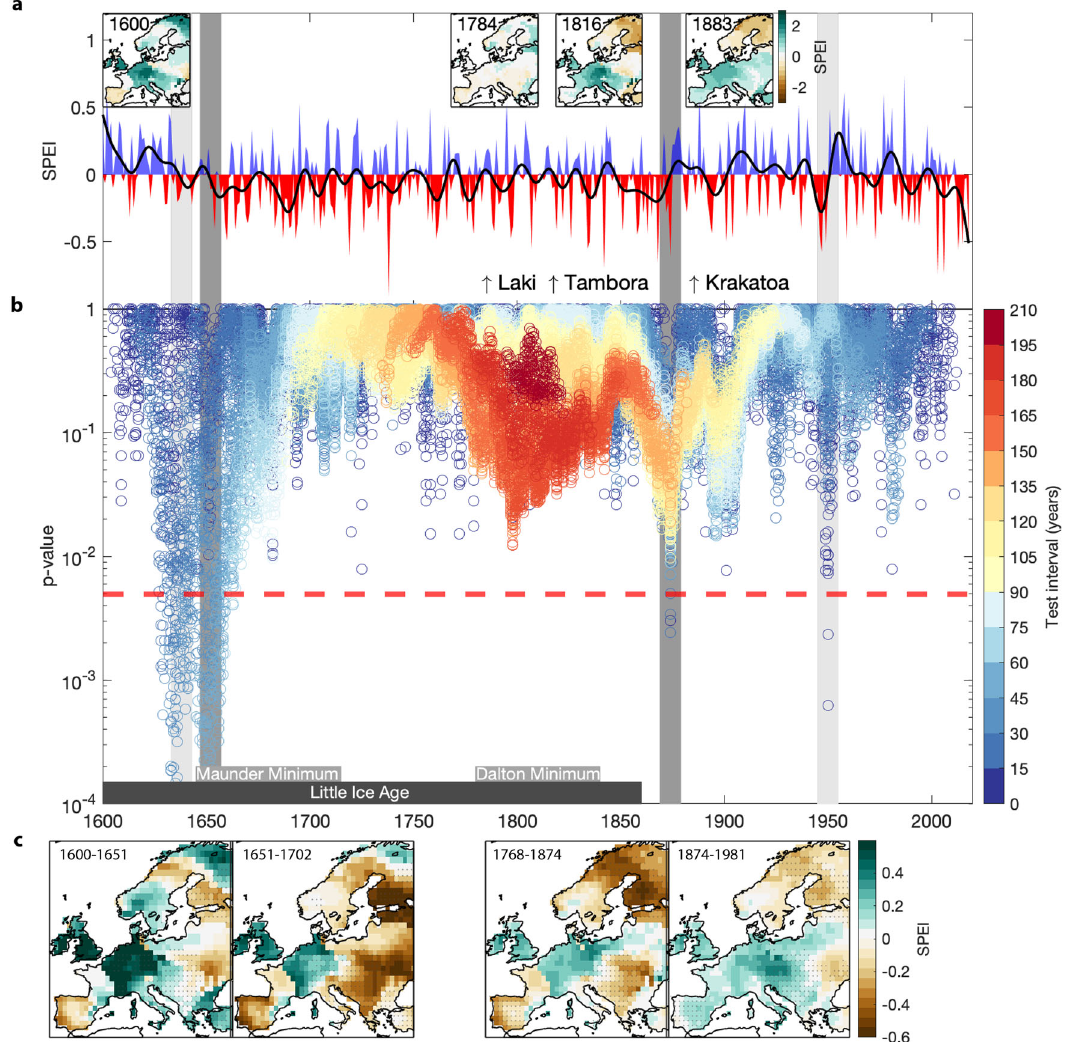
Fig. 3 Reconstructed European summer variability. a European fi eld average of reconstructed SPEI (JA) from 1600 to 2018. A smoothed 13-year Chebyshev low-pass fi lter is shown as a black line. Insets show the spatial reconstructed SPEI for 1600, 1784, 1816 and 1883. b Change point analysis of European fi eld average using the Wilcoxon rank-sum tests for sliding time intervals between 5- and 200-year time windows. The colour of a point corresponds to the tested time interval, and the year corresponds to the centre of the tested data. Signi fi cant change points are below the red horizontal line ( p < 0.01). The Little Ice Age ( ≈ 1300 – 1860 CE) and the Maunder Minimum (1645 – 1715) periods are highlighted. Vertical lines indicate signi fi cant long-term (dark, >30 years) and short-term (light) change points. c Average conditions before and after signi fi cant long-term change points in 1651 (left) and 1874